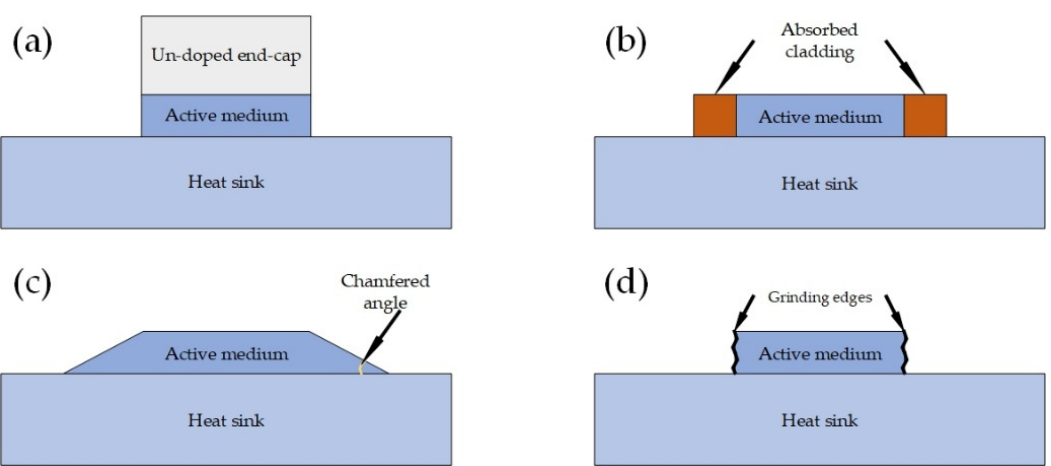
Figure 5. Methods to suppress ASE: ( a ) bonding undoped YAG crystals; ( b ) absorber cladding (Cr 4+ :YAG crystal) ; ( c ) edge chamfering; ( d ) edge grinding.